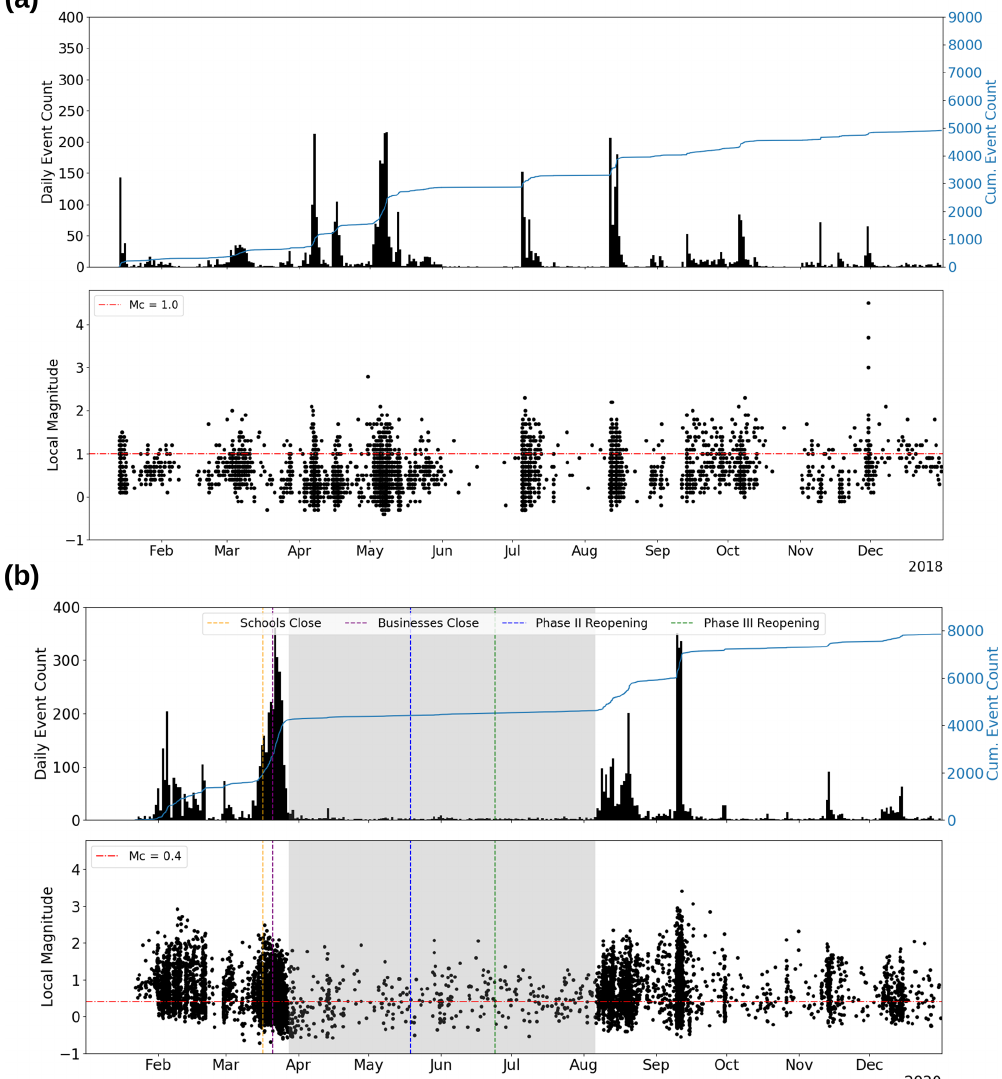
Figure 3. Temporal evolution of seismicity within the KSMMA (daily counts in black, cumulative counts in blue) for 2018 and 2020. Dis- tinct temporal patterns can be observed in both years, in particular in the spring and autumn, associated with ongoing hydraulic fracturing operations in the area. (a) Seismic events reported by NRCan between 1 January and 31 December 2018 (inclusive) (Visser et al., 2020). Magnitudes were calculated using the M L formula of Hutton and Boore (1987). The magnitude of completeness ( M c ) is reported as M L 1.0. (b) Seismic events recorded by the newly installed EO network (and incorporating data from public stations) from 1 January to 31 Decem- ber 2020 (inclusive). Magnitudes were calculated using the specific local magnitude formula for the KSMMA introduced by Babaie-Mahani and Kao (2020). The magnitude of completeness ( M c ) is estimated as M L 0.4. The timing of different lockdown scenarios affecting the KSMMA are shown as vertical dashed lines. The time period from April to August 2020 represents the period of relative quiescence anal- ysed in this paper (grey background) and is shown in more detail in Fig. 5. The time lag for seismicity build up after the Phase III reopening reflects the time required for operations in the area to be